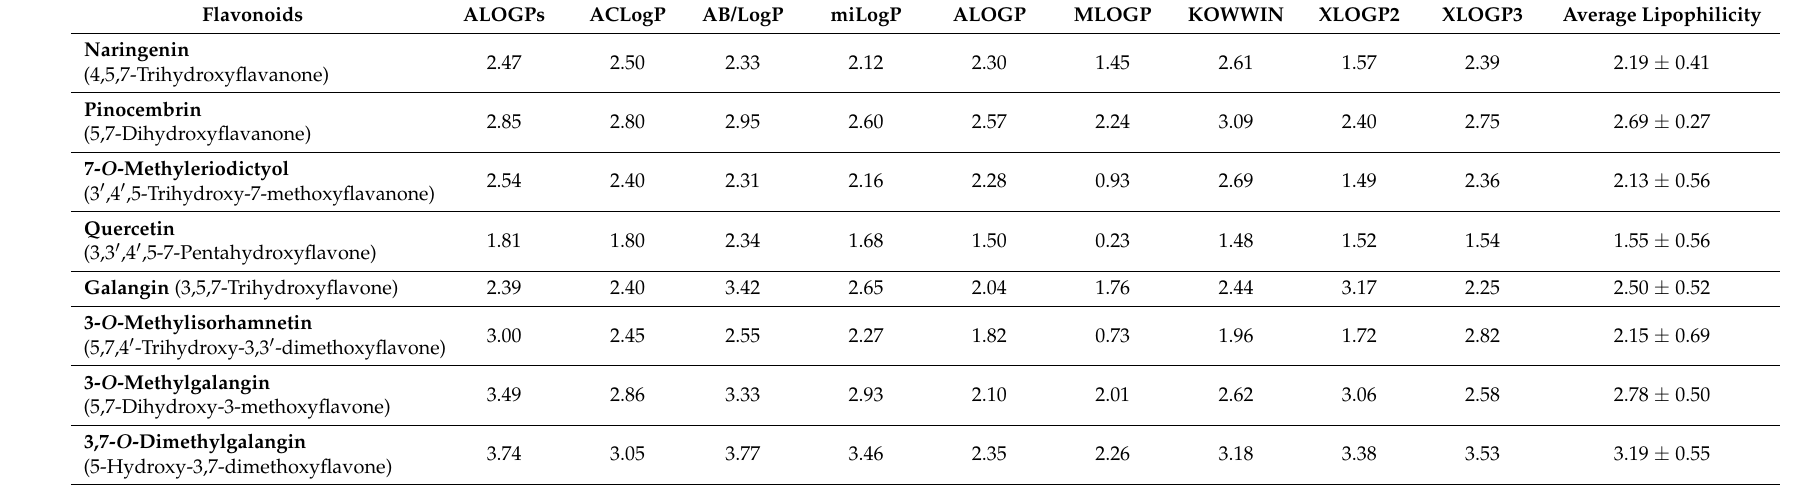
Table 3. Data of lipophilicity